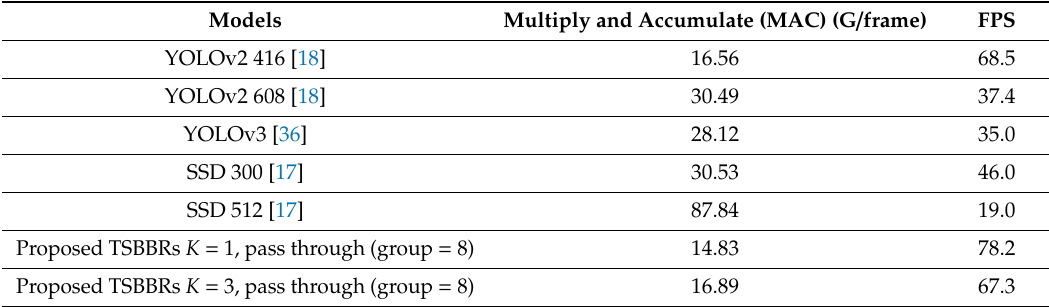
Table 11. Comparison of computational cost.